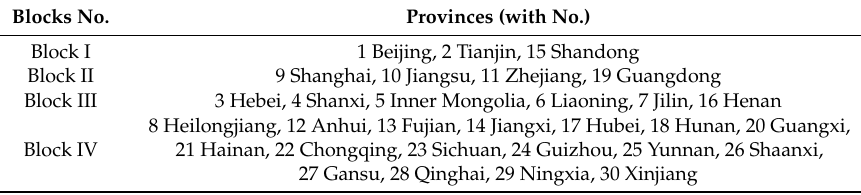
Table 7. Inter-provincial transportation carbon emission aggregation results.